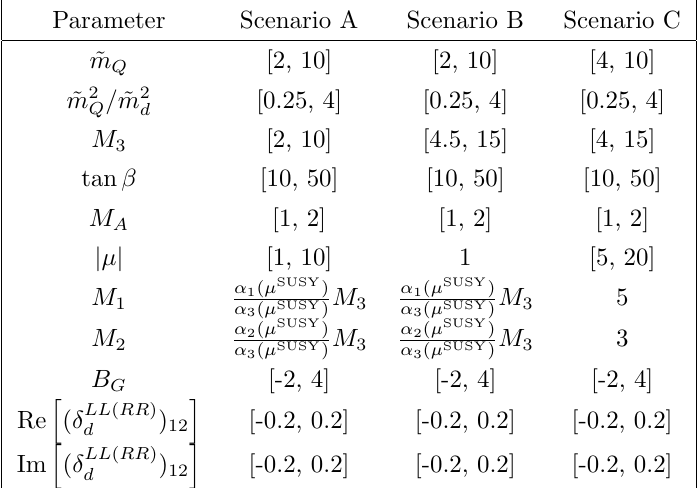
Table 2 . Scan ranges for scenario A, B (motivated by Higgsino Dark Matter) and C (motivated by Wino Dark Matter). All masses are in TeV. The nuisance parameter B G appears in the chromomagnetic-dipole contribution to " 0 =" K K